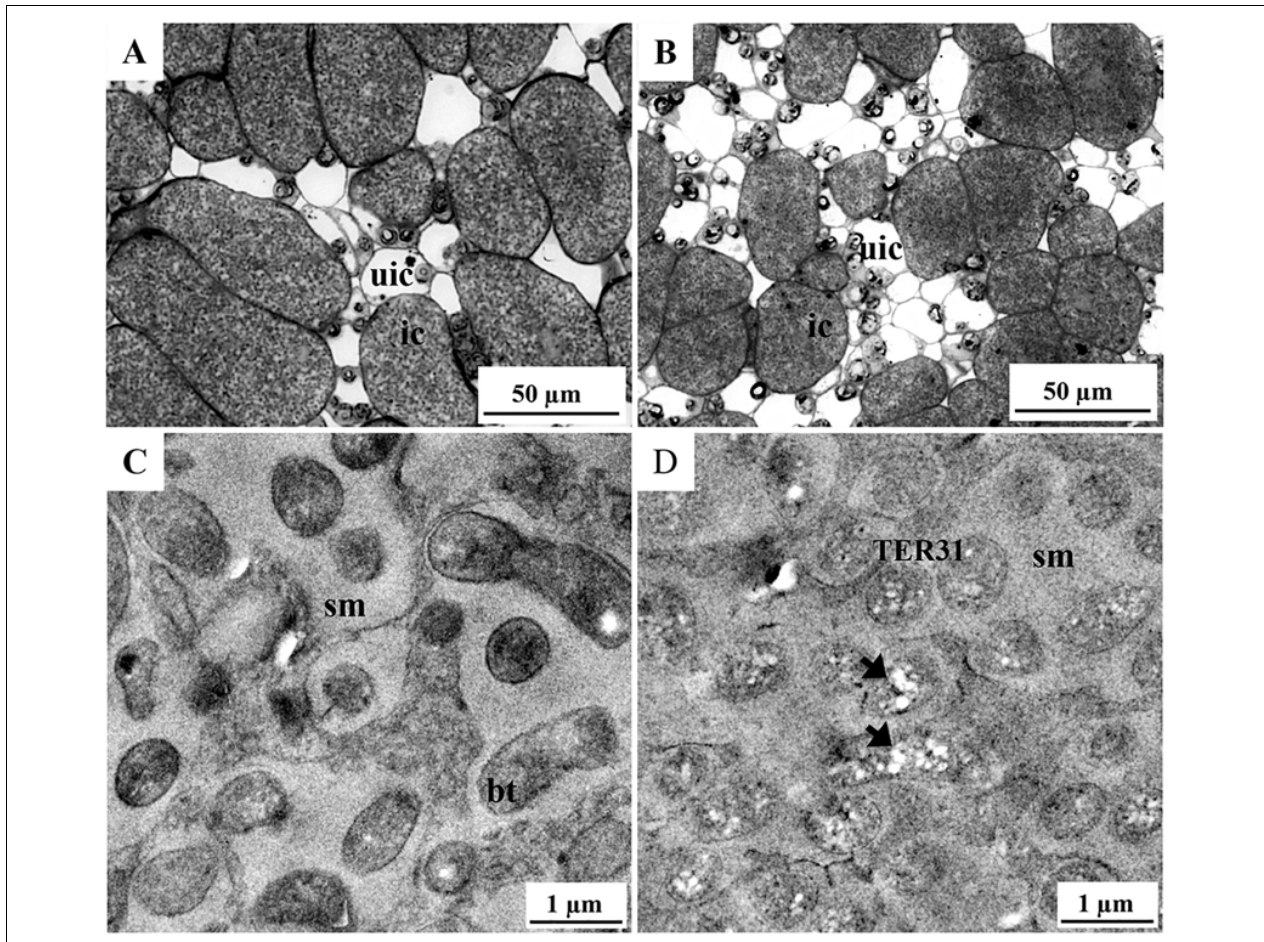
FIGURE 4 | Histology and transmission electron microscopy of infected cells from nodules generated on roots inoculated with TER31 and CFNX182-1 strains. Semi-thin and ultra-thin sections of nodule central tissue (21 dpi) were analyzed by bright field (A,B) and transmission electron microscopy (C,D) . Samples: (A,C) nodules from roots inoculated with CFNX182-1 and (B,D) TER31. bt, bacteroids; ic, infected cells; sm, symbiosome matrix; TER31, intracellular TER31 bacteria; uic, uninfected cells; arrowheads, PHB-like storage